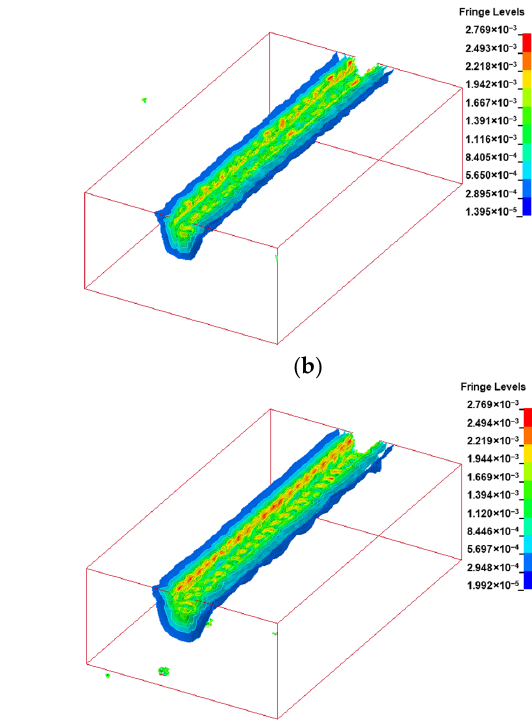
( d ) Figure 19. The contact force of BF 5mm disc cutter with different blade widths. ( a ) Normal force;